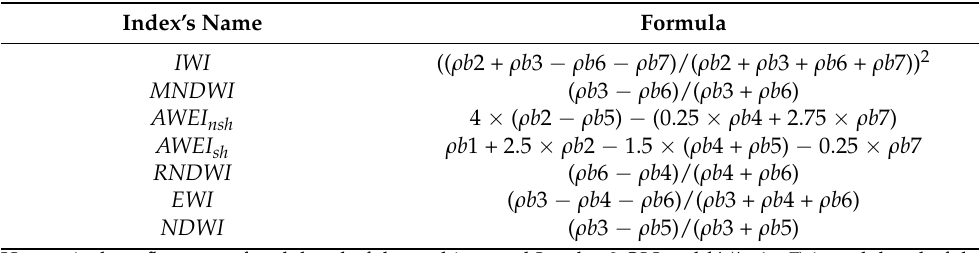
Table 2. Comparison of various spectral water indices.